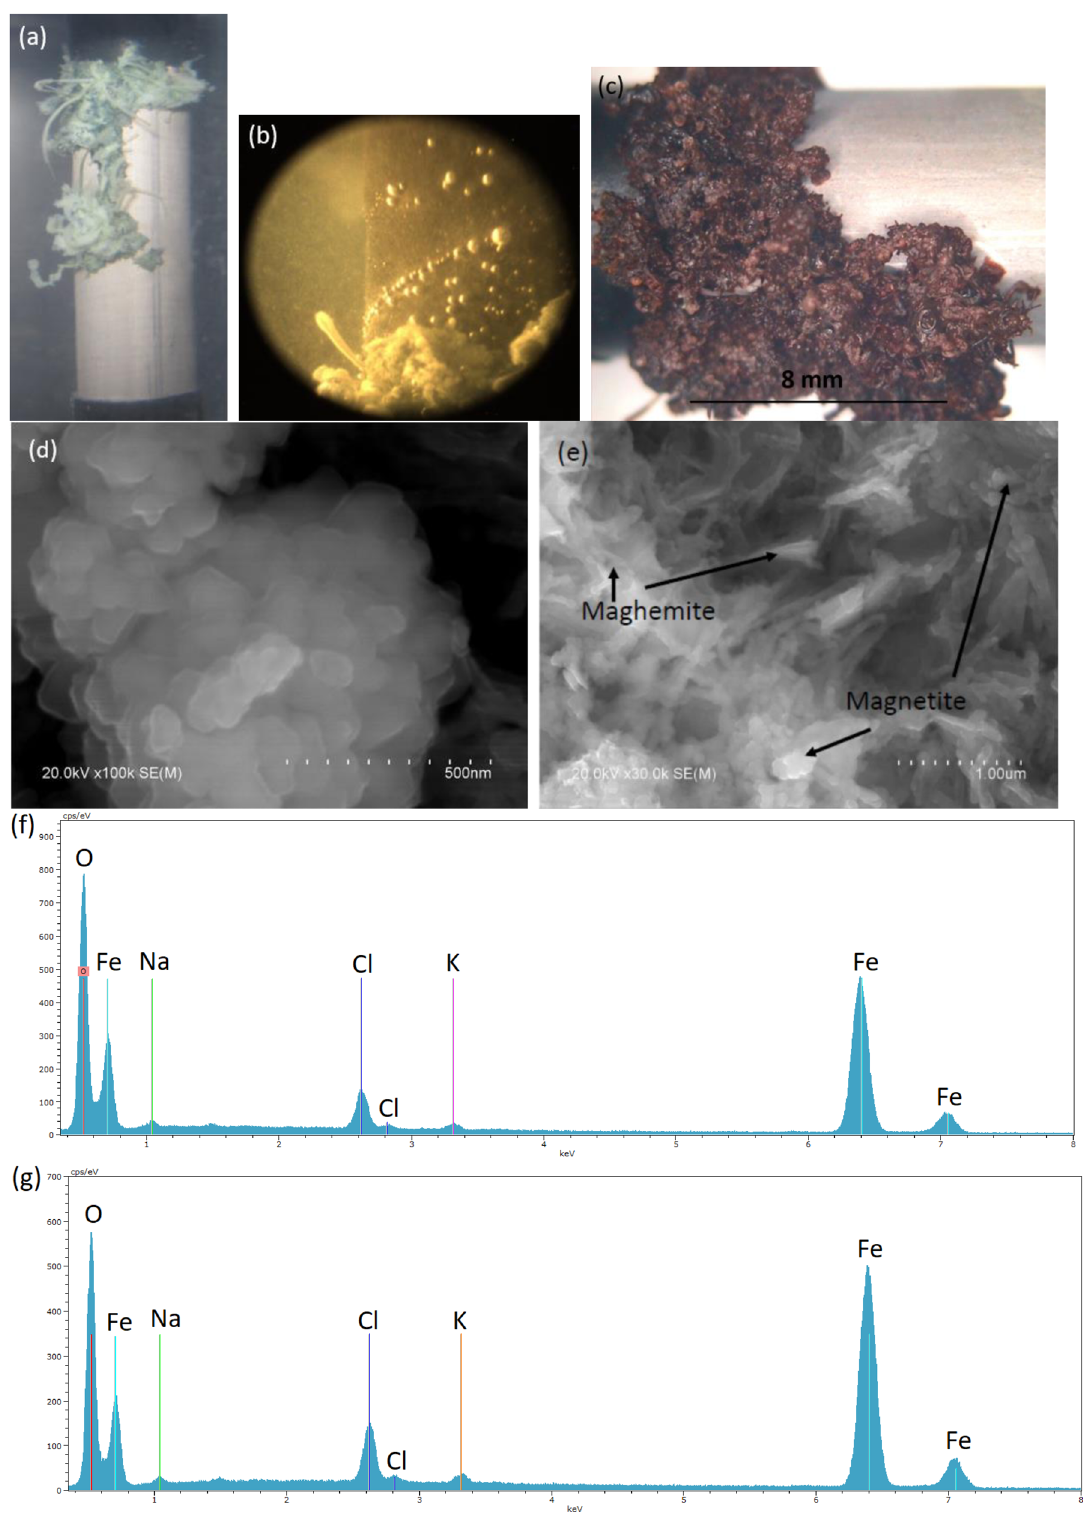
Figure 13: ( a ) Green rust – corrosion products of HSHCsw in deaerated ( ≤ 0.5ppm in oxygen gas content ) pH 13.4 electrolyte at 1M Cl − and − 350 mV taken by digital camera. ( b ) Hydrogen gas produced during active pitting corrosion taken by boroscope. ( c ) Brownish corrosion products ( light microscope: 15 ×) – obtained after the green rust was exposed to air for some time. ( d ) SEM images of magnetite Fe 3 O 4 . ( e ) SEM images of magnetite Fe 3 O 4 and maghemite γ - Fe 2 O 3 . ( f ) The EDS spectrum of magnetite Fe 3 O 4 . ( g ) The EDS spectrum of maghemite γ - Fe 2 O 3